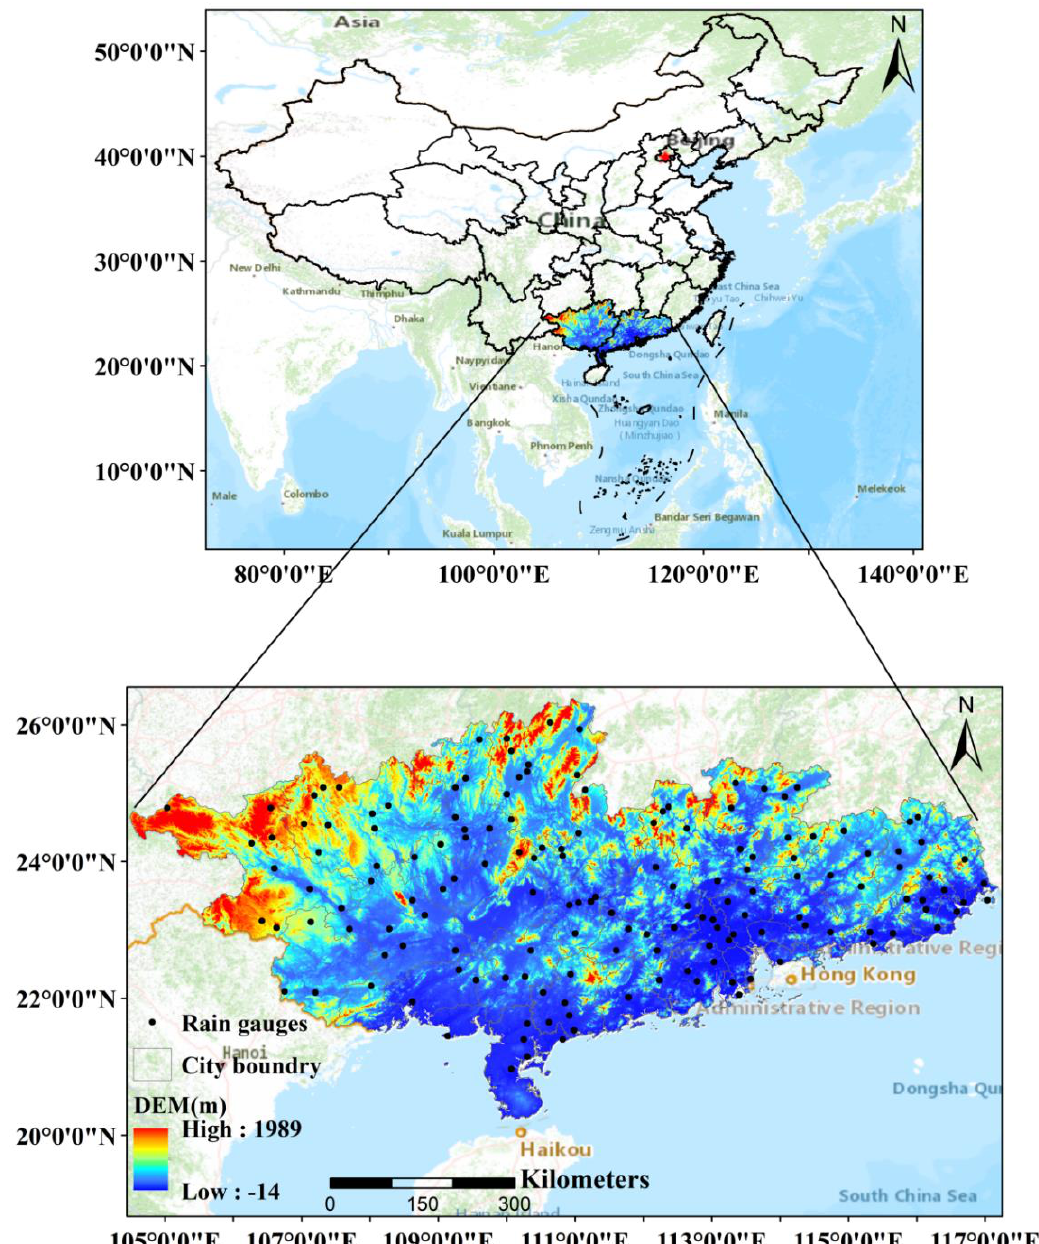
Figure 1. Spatial patterns of DEM over southern China, i.e., Guangdong and Guangxi province.